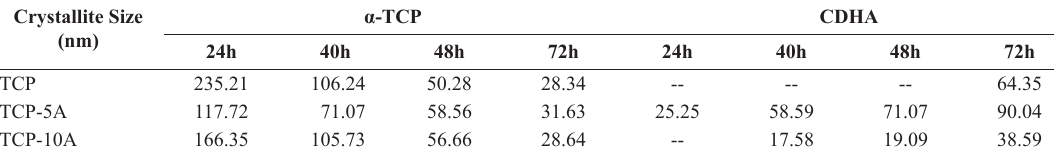
Table 3. Crystallite size (τ) of α-TCP and CDHA particles during hydrolysis. Crystallite Size (nm)